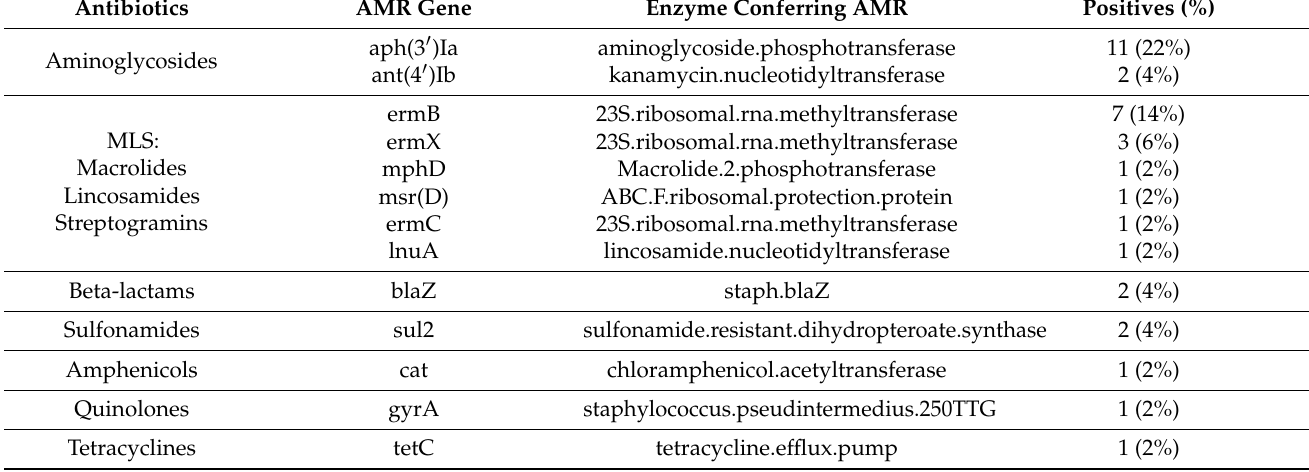
Table 1. Overview of antibiotics that the detected AMR genes confer resistance to, as well as en- zymes involved in conferring resistance, with total number of positive urine samples collected from 50 clinically healthy dogs (percentage of positive samples is included in parenthesis). Beta-lactam antibiotics cover penicillins, cephalosporins, and related compounds. The targeted AMR genes could confer resistance to 44 antibiotics evaluated in the workflow, including Amikacin, Amoxicillin, Ampicillin, Azithromycin, Cefadroxil, Cefazolin, Cefovecin, Cefoxitin, Cefpodoxime, Ceftazidime, Ceftiofur, Cephalexin, Cephalothin, Chloramphenicol, Clavamox, Clindamycin, Ciprofloxacin, Col- istin, Doxycycline, Enrofloxacin, Florfenicol, Gentamicin, Imipenem, Levofloxacin, Lincomycin, Marbofloxacin, Metronidazole, Minocycline, Mupirocin, Neomycin, Nitrofurantoin, Orbifloxacin, Oxacillin, Penicillin, Penicillin G, Piperacillin, Pradofloxacin, Rifampin, Sulfonamide, Tetracycline, Timentin, Ticarcillin, Tobramycin, and